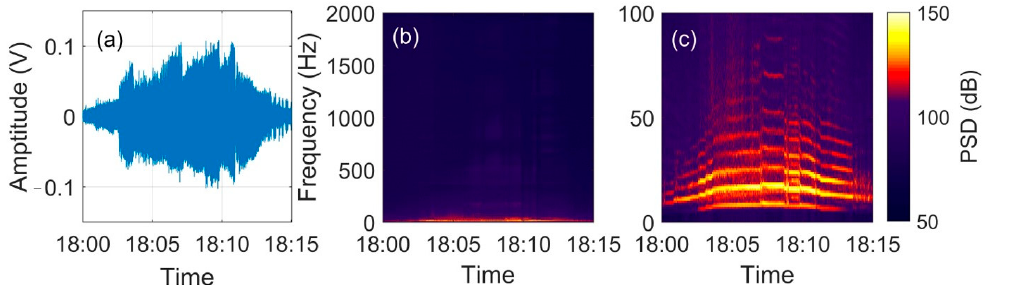
Figure 3. The signal received by the C058 hydrophone at a depth of 700m from 18:00 UTC+8 to 18:15 UTC+8 on 1 October 2016. ( a ) Time–domain signal. ( b ) Time–frequency spectrum. ( c ) Time–frequency spectrum between 0 Hz and 100 Hz.